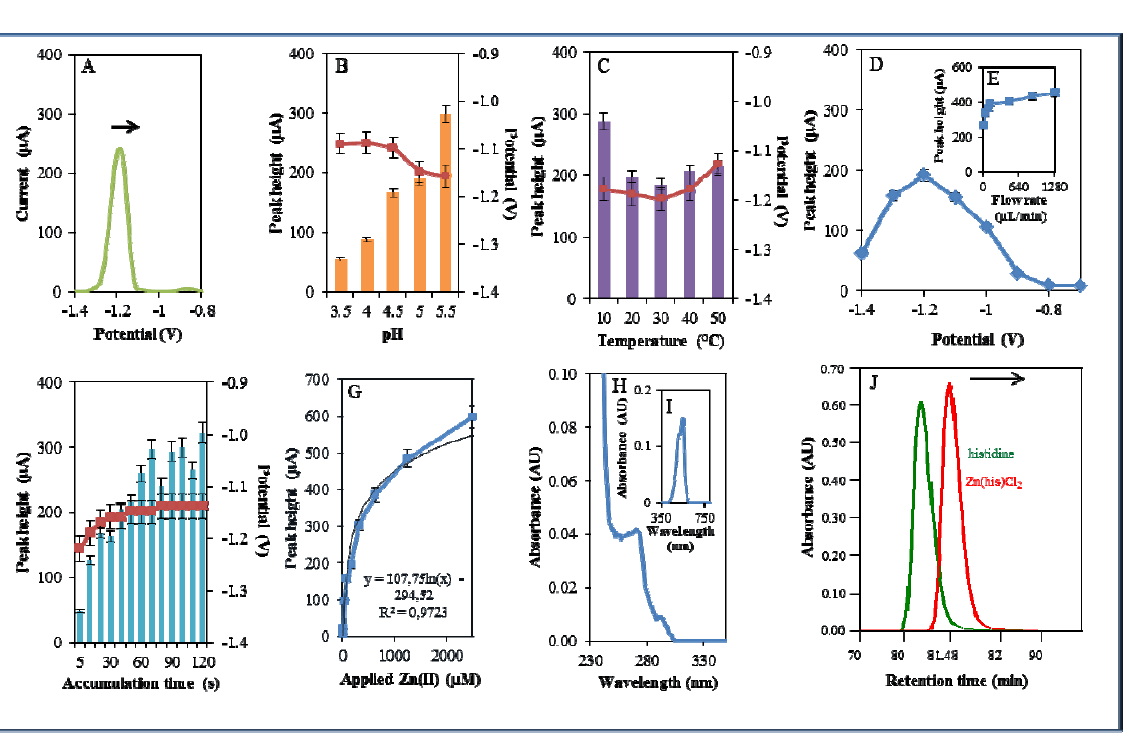
2 in 0.2 M acetate buffer, pH 5, 2 2 voltammogram. 2 2